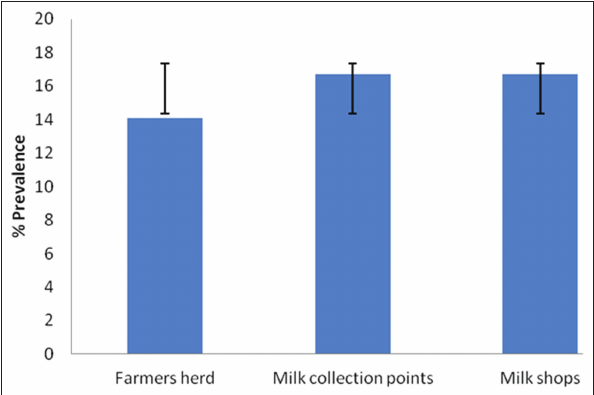
Figure-2: Prevalence of Staphylococcus aureus in different collection sites from cows’ milk obtained from smallholder farms in Mbeya and Mbozi districts, Table-1: Antibiotic drug resistance for Staphylococcus aureus isolates from cows’ milk obtained from smallholder farms in Mbeya and Mbozi districts, Tanzania (n=21). Antibiotics Number of resistant isolates (%)